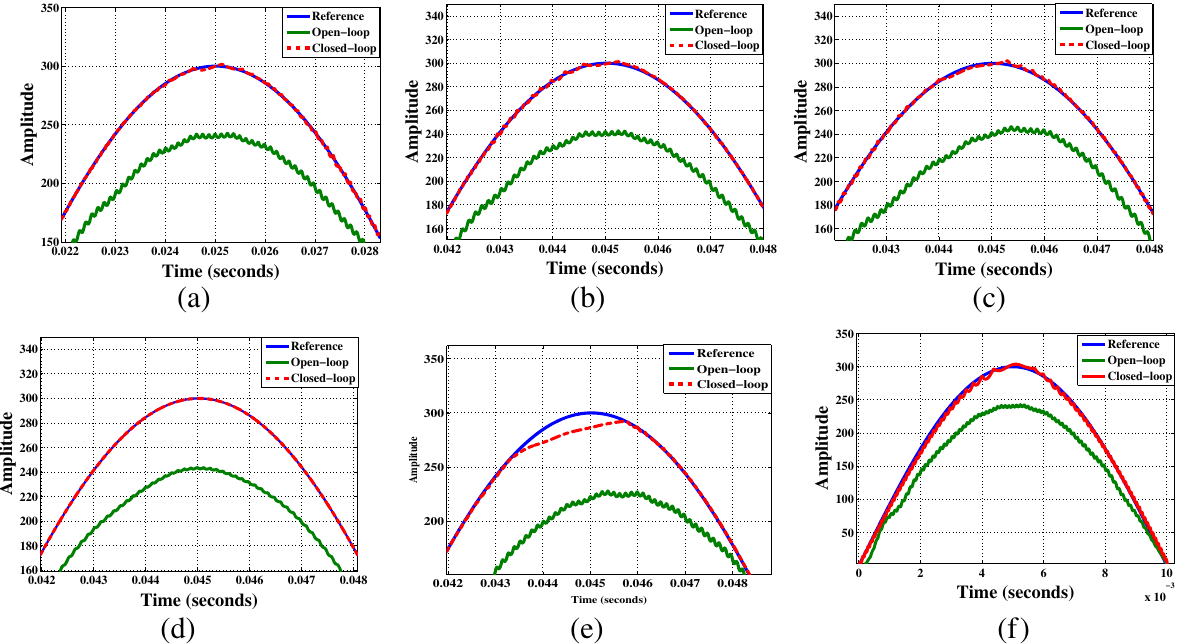
Fig. 20 Grid Voltage Tracking Using PID Controller for ( a ) Consumer Load, ( b ) Dynamic Load, ( c ) Harmonics Load, ( d ) Unknown Load, ( e ) Asynchronous Machine Load, ( f ) Non-linear Load. The Blue (-) and Green (-) Solid Line Represents the Reference and Open-Loop Voltage Respectively and Red (- -) Dashed Line Represents the Closed-Loop Grid